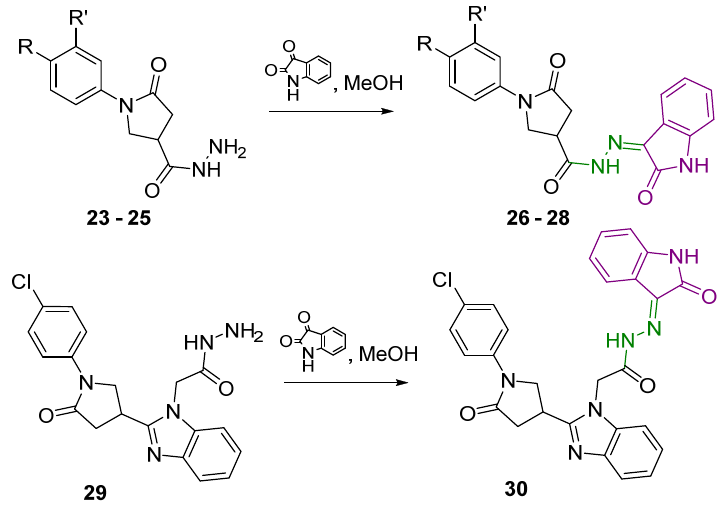
and 2-oxindole moiety is represented in purple